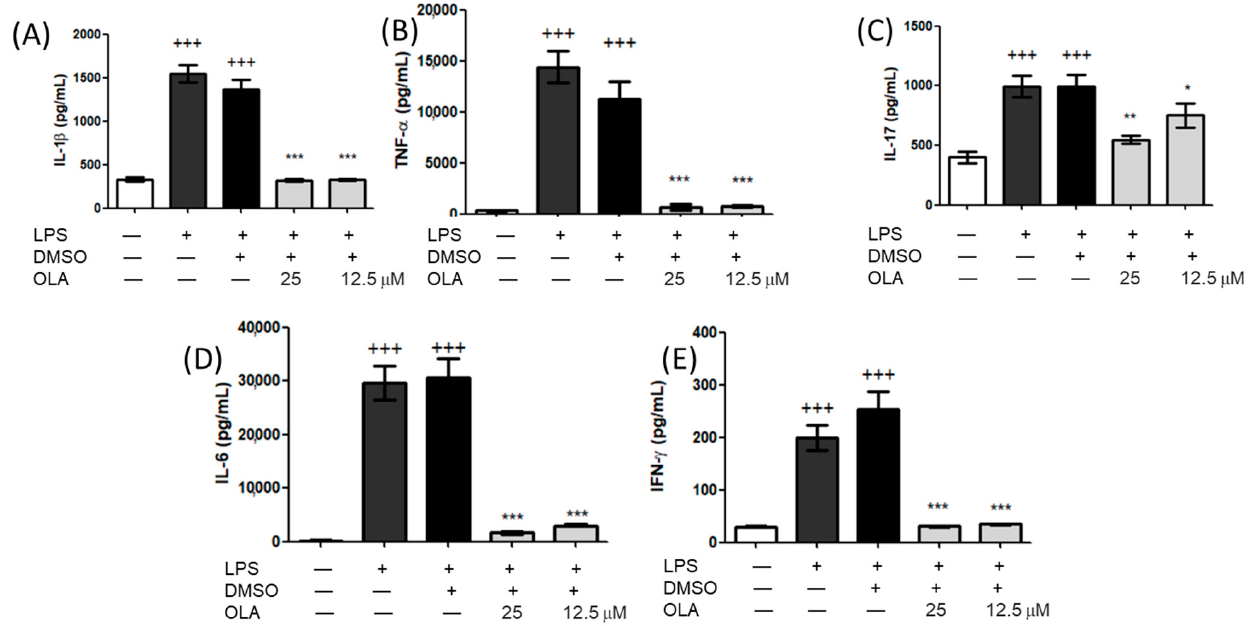
Figure 3. Effects of OLA on IL-1 β ( A ), TNF- α ( B ), IL-17( C ), IL-6 ( D ), and IFN- γ ( E ) levels . Cells were pretreated for 30 min(min) with OLA and LPS-stimulated (5 μ g/mL) for 18 h. Control cells were also treated with DMSO (solvent control) and LPS or nontreated. Data are expressed as means ± SEM ( n = 7). +++ p < 0.001 vs. control cells (no stimulated); * p < 0.05, ** p < 0.01, *** p < 0.001 vs. LPS − DMSO control-treated cells.